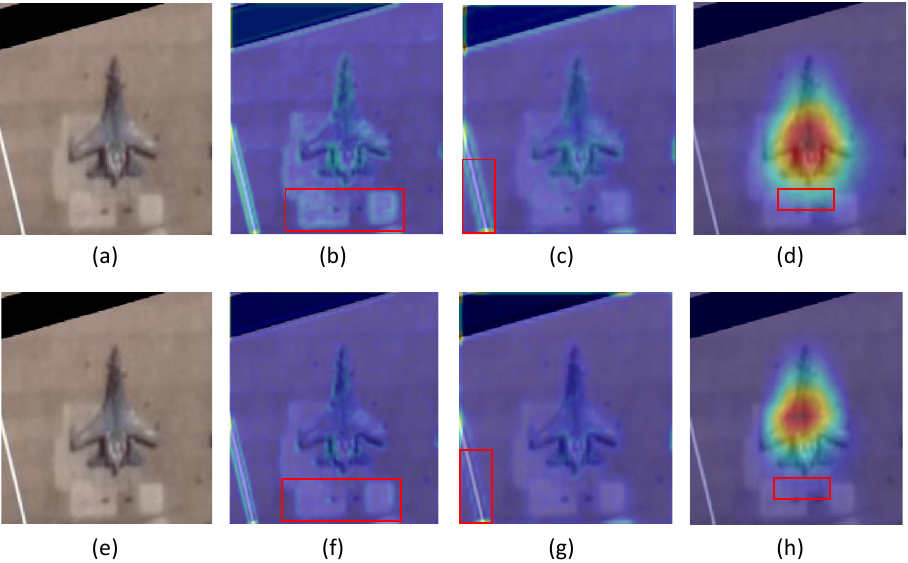
Figure 11. Heatmaps of aircraft Type40 before and after adding non-locally enhanced module. The first row is the phenomenon without inserting the non-locally enhanced module, and the second row is the phenomenon after inserting this module, and from left to right are the original image, heatmap of conv2_2, heatmap of conv3_1 and heatmap of conv5_4,